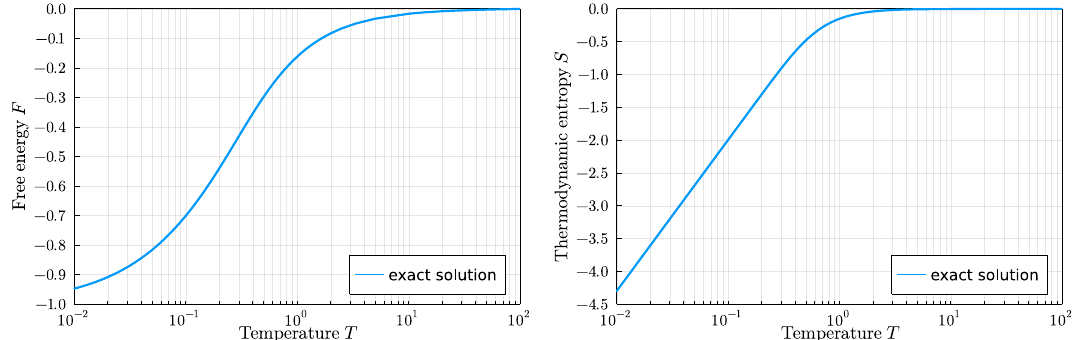
Figure 2: Free energy F and thermodynamic entropy S per site for the one- dimensional classical Heisenberg chain. The negative thermodynamic entropy is a particular feature of the